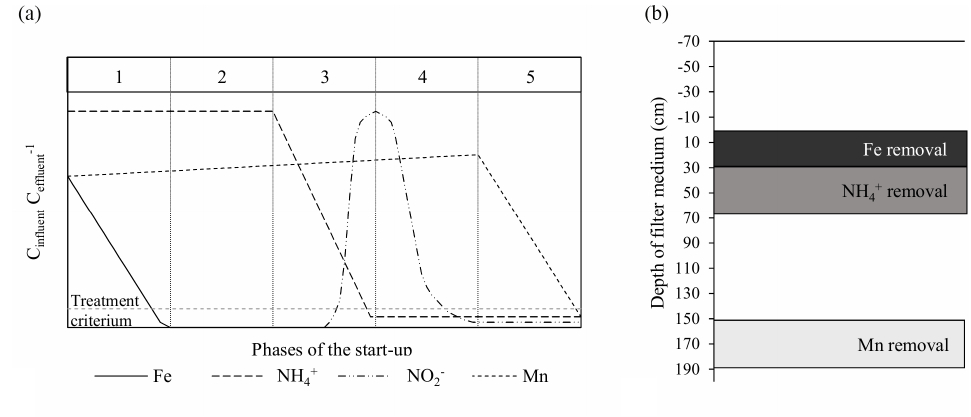
Figure 9. (a) Conceptual phases of the start-up period in drinking water biofilters (modified from Frischherz et al., 1985). (b) Stratification of iron, ammonium and manganese removal in Filter